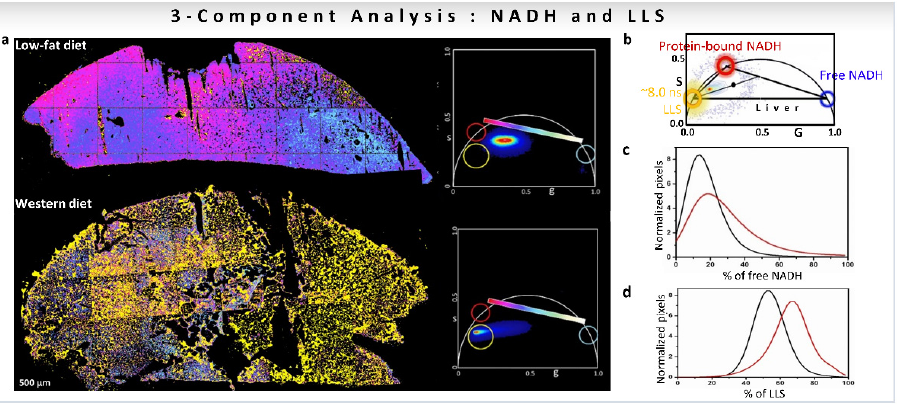
Figure 8. Three-component analysis (known lifetimes of the components) using a graphical approach for understanding of effect of diet on mice liver. ( a – d ) Quantification of the presence of oxidized lipids in mice fed with Western diet vs. low-fat diet using three-component analysis. ( a ) Color-coded phasor-FLIM liver images of mice fed with low-fat diet (LF) or Western diet (WD). The free-to-protein-bound ratio (not including LLS) is color-coded using a magenta to cyan colormap with a yellow overlay for LLS. The corresponding phasor plots are shown for each condition. ( b ) Blue, red and yellow circles on the phasor plot represent the phasor positions of free and protein-bound NADH, and long lifetime species (LLS), respectively. Histograms showing the percentage of free NADH ( c ) or LLS species ( d ) for the LF (black) and WD (red) diet, respectively. (Panels adapted with permission from [32]).